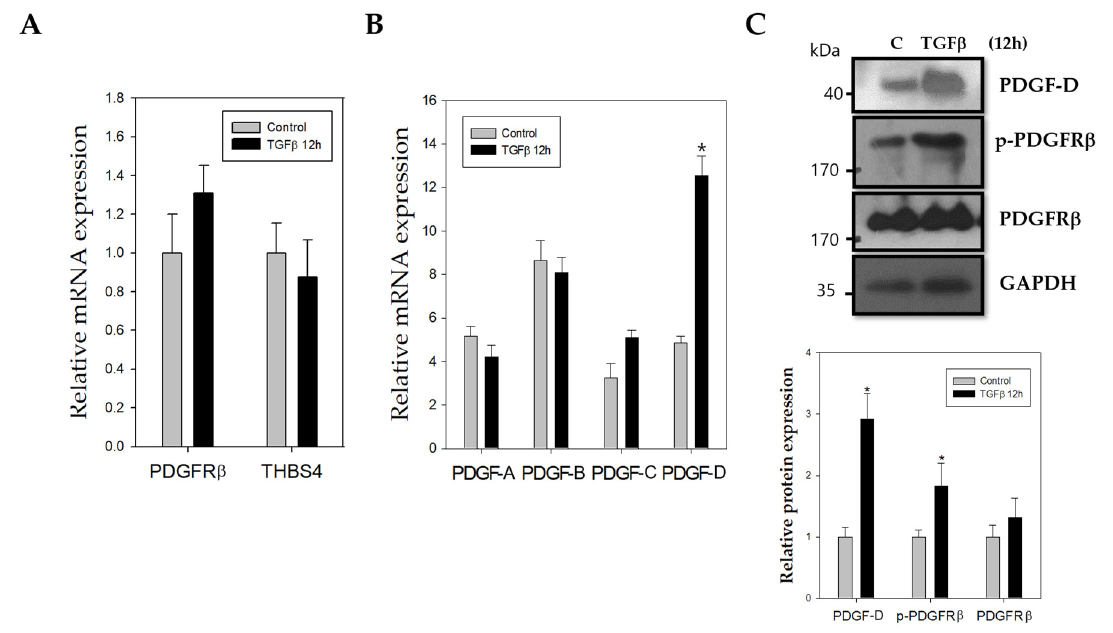
Figure 2. Effect of TGF β on mRNA levels of THBS4, PDGFR β , and PDGFR β ligands. Relative mRNA expression levels as determined with real-time polymerase chain reaction (PCR) for ( A ) PDGFR β , THBS4, ( B ) PDGF-A, PDGF-B, PDGF-C, and PDGF-D of DLD-1 cells cultured in the presence (TGF β 10mM) or absence (control) of TGF β for 12 h. ( C ) Western blot with anti-PDGF-D, p-PDGFR β , and PDGFR β antibodies in DLD-1 cells cultured in the presence (TGF β 10 µM) or absence (control) of TGF β for 12 h. Three independent experiments were performed in duplicate. * p < 0.05 when compared with the control t- test .